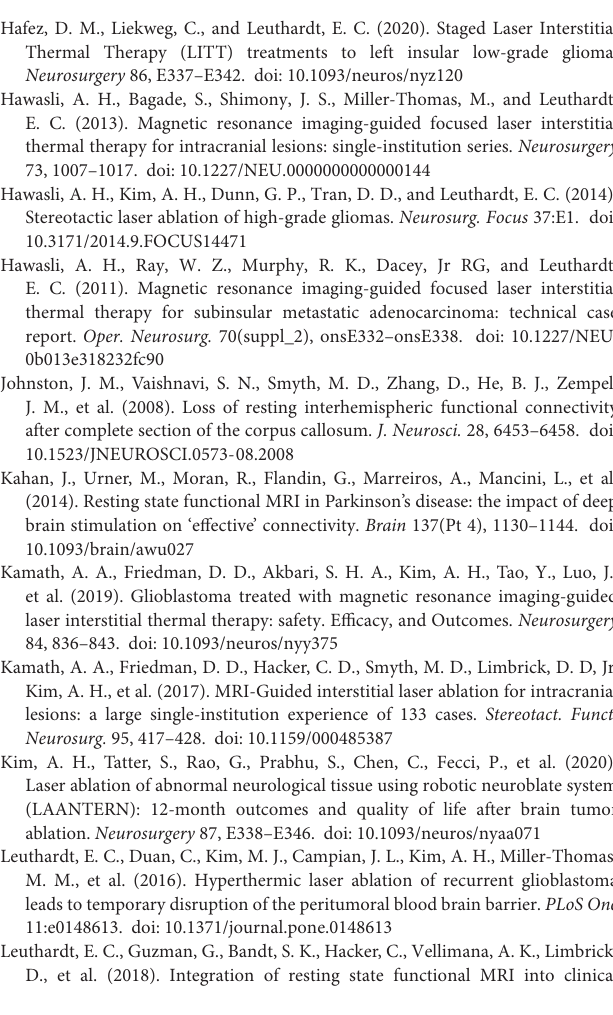
Supplementary Figure 1 | Heat maps representing tumor-affected regions in the craniotomy and LITT (laser interstitial thermal therapy) treatment groups. T1-weighted post-contrast images and surrounding FLAIR hyperintensity were used for tumors with contrast enhancement. FLAIR hyperintensity was used for tumors without contrast